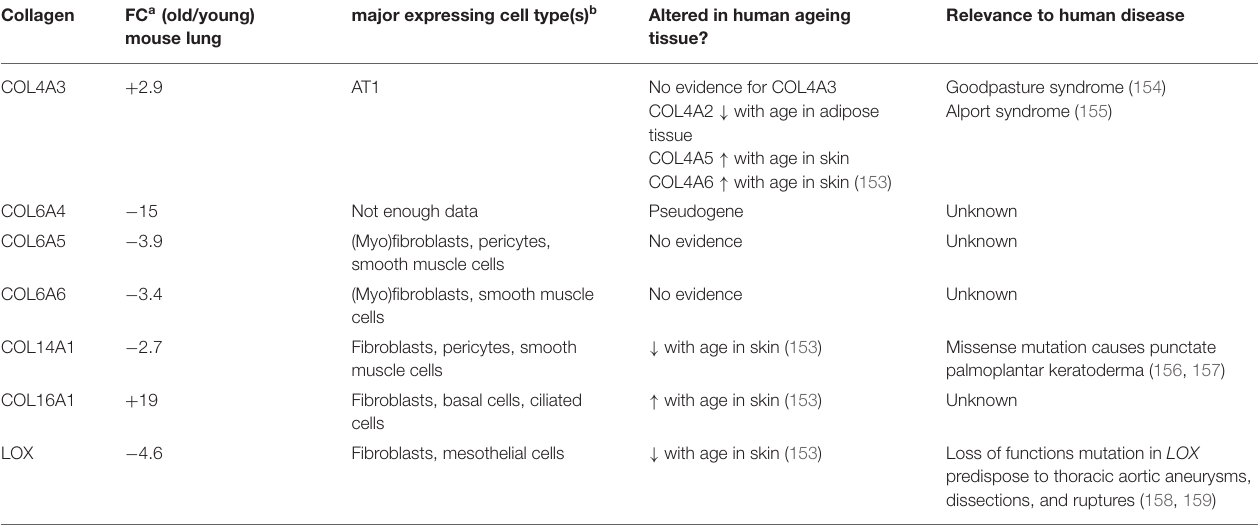
TABLE 2 | Overview on collagens and collagen biosynthetic proteins observed to be regulated with age in the mouse lung.